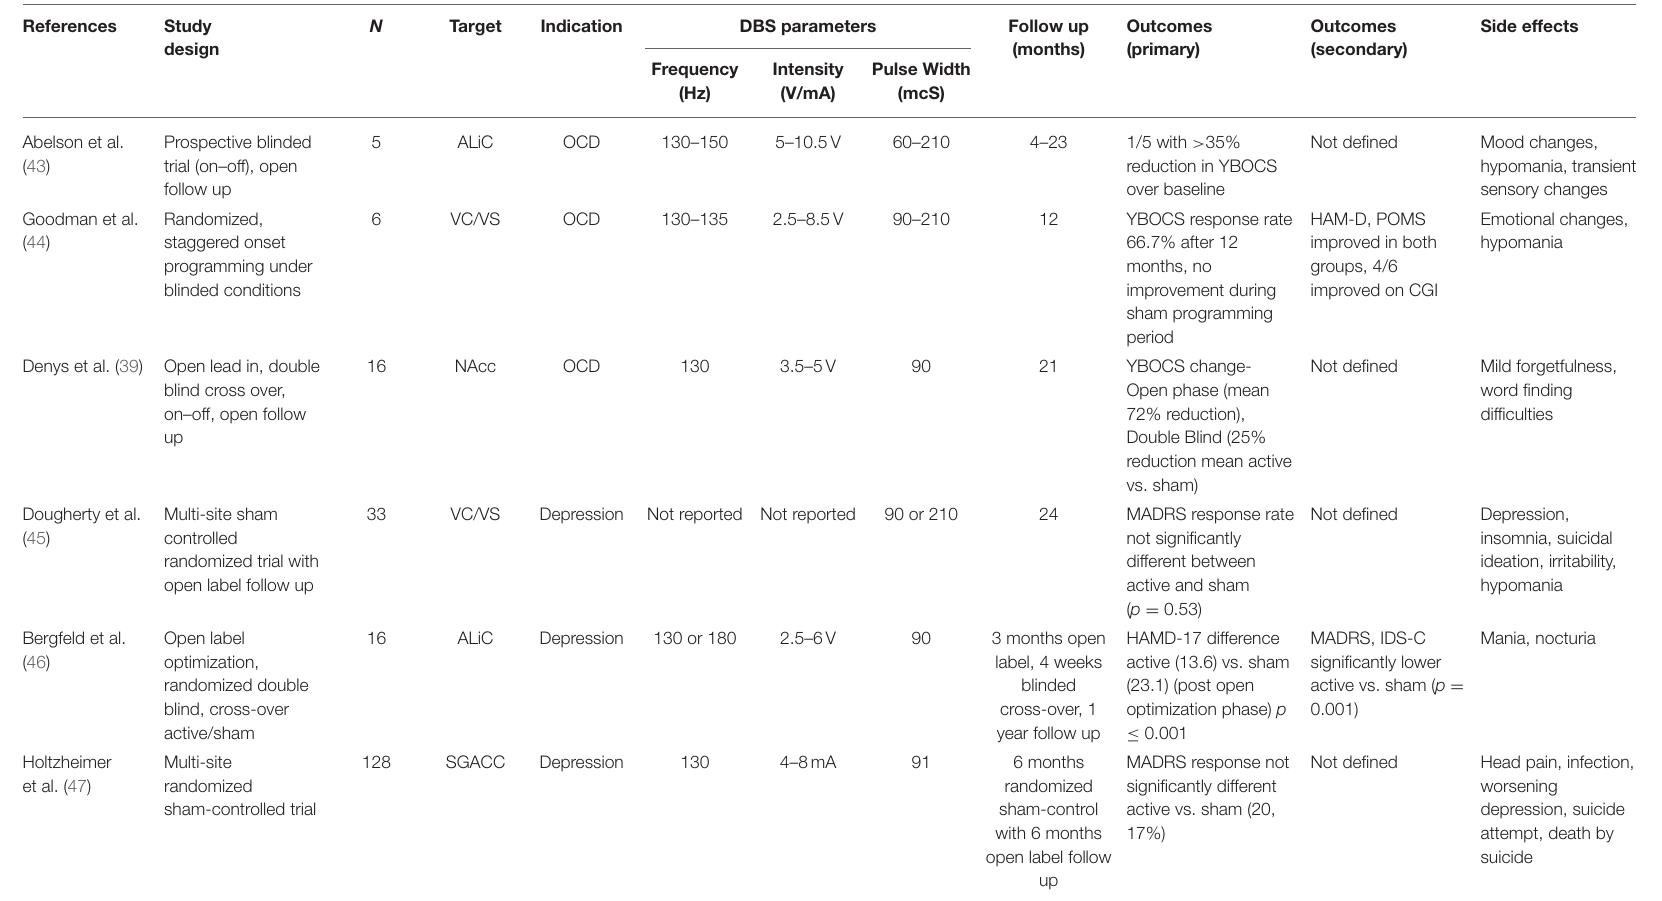
TABLE 1 | Summary of clinical data on deep brain stimulation for psychiatric